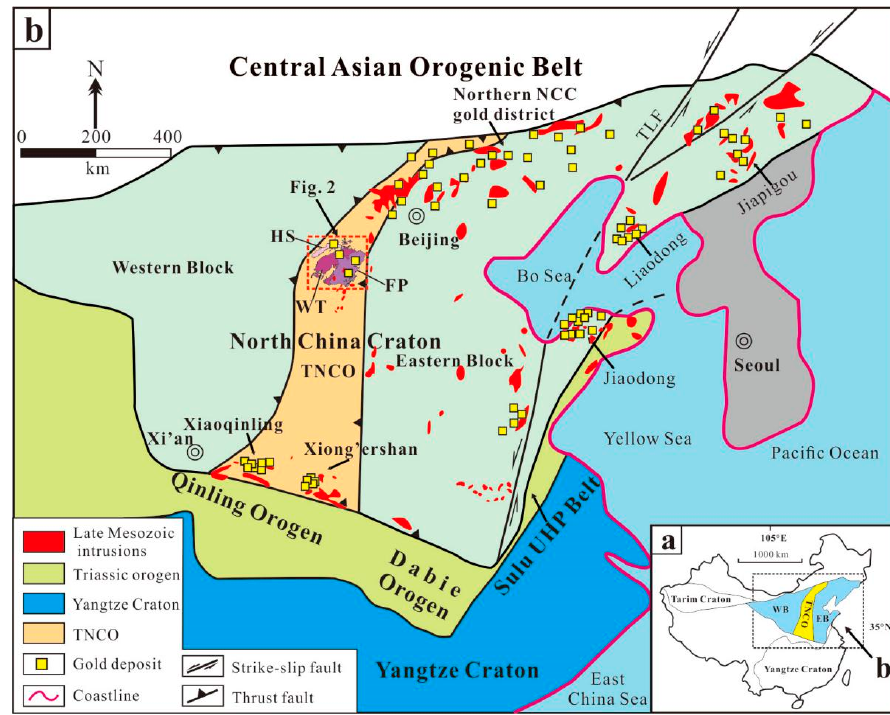
Figure 1. ( a ) Tectonic map showing the location of the North China Craton (modified after Reference [10]); ( b ) geological map of the North China Craton showing the tectonic divisions, distribution of metamorphic core complexes, late Mesozoic intrusions, and major, large gold districts (modified from References [11–19]). Abbreviations: EB, Eastern Block; WB, Western Block; TLF, Tan-Lu Fault; TNCO, Trans-North China Orogen; FP, Fuping Complex; WT, Wutai Complex; and HS, Hengshan Complex.